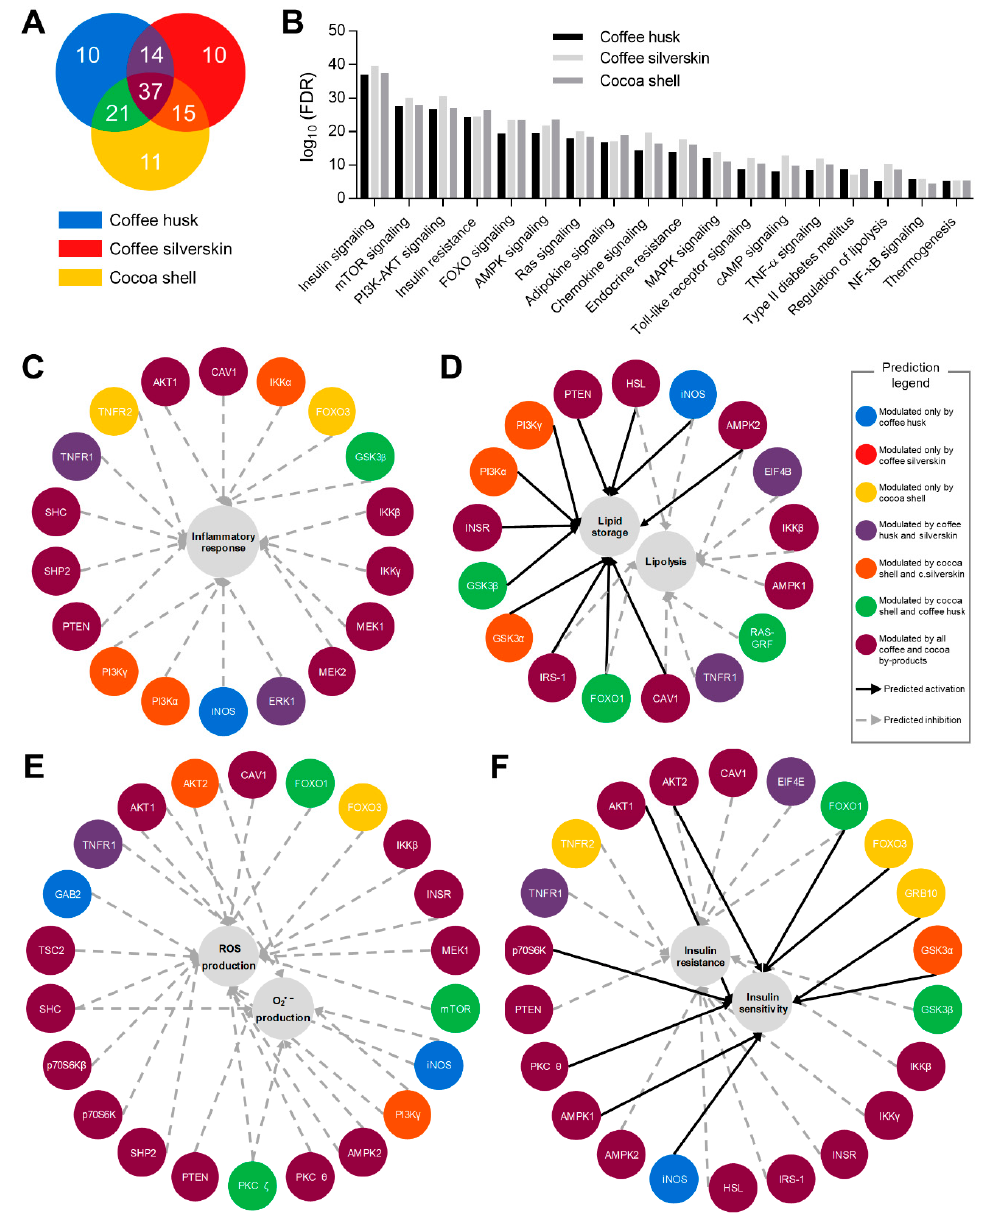
Figure 3. Venn diagram showing the overlap of di ff erentially phosphorylated proteins in adipocytes upon the treatment with co ff ee husk, co ff ee silverskin, and cocoa shell aqueous extracts (31–500 µ g / mL) ( A ). KEGG pathways associated with the di ff erentially phosphorylated proteins ( B ). Downstream e ff ect analysis of co ff ee and cocoa extracts on inflammatory response ( C ), lipid storage and lipolysis ( D ), oxidative stress ( E ), and insulin resistance ( F ).